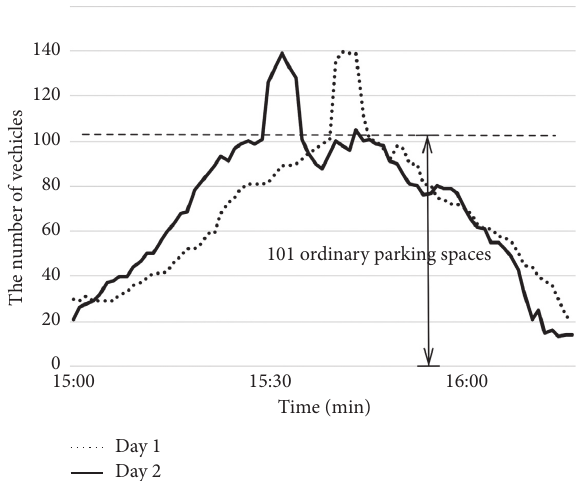
Figure 8: The cumulative number of vehicles during the